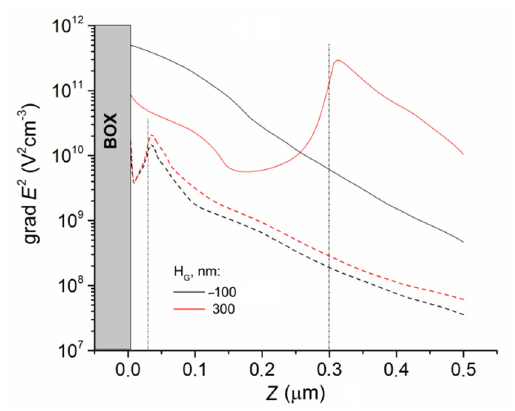
Figure 6. Dependences of grad E 2 ( Z ) calculated in the cross section of B near the sensor (dashed lines) and near the DEP-2 electrodes (straight lines) with different heights. V bg = 0.5 V. L = 1.2